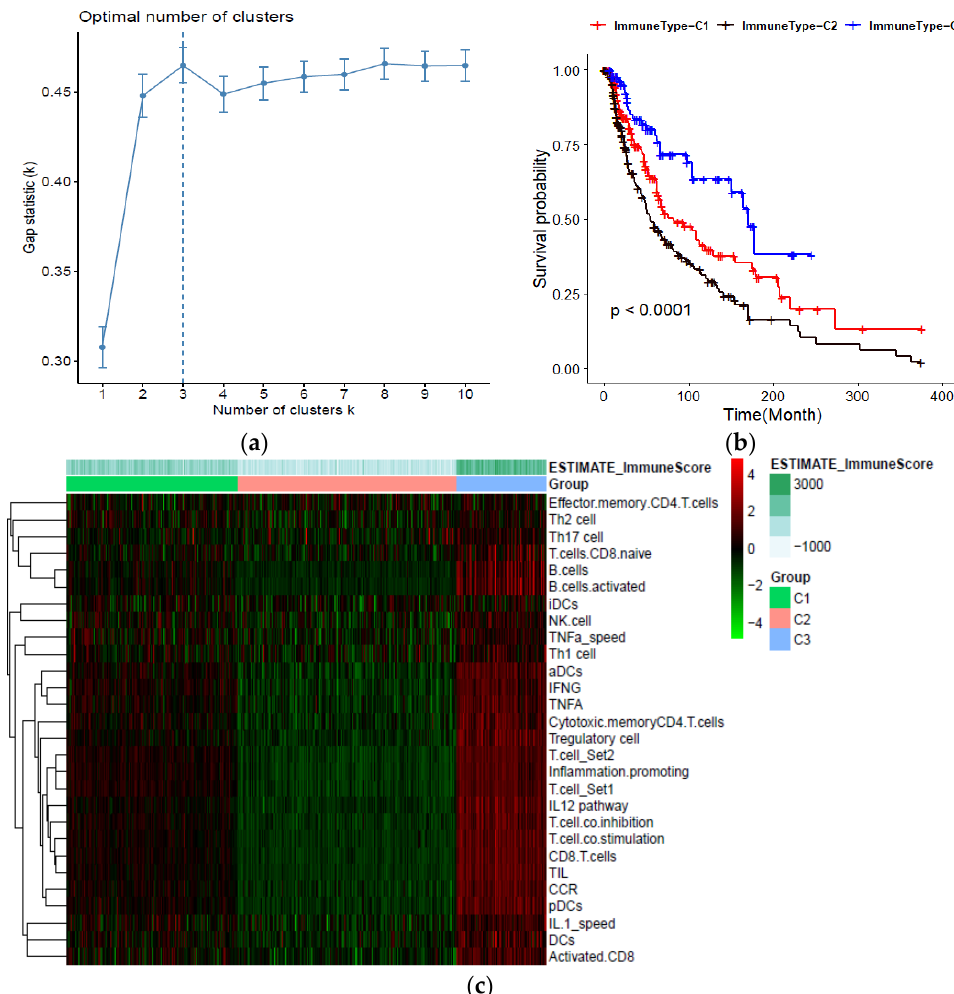
Figure 1. Classification of human skin cutaneous melanoma (SKCM) based on immune cells infiltration; ( a ) Estimation of optimal cluster number by gap statistics analysis; ( b ) Kaplan–Meier plot of overall survival for patients in the three immune-related groups; ( c ) Heatmap of the immune subtypes based on the ssGSEA scores for 28 immune gene sets.